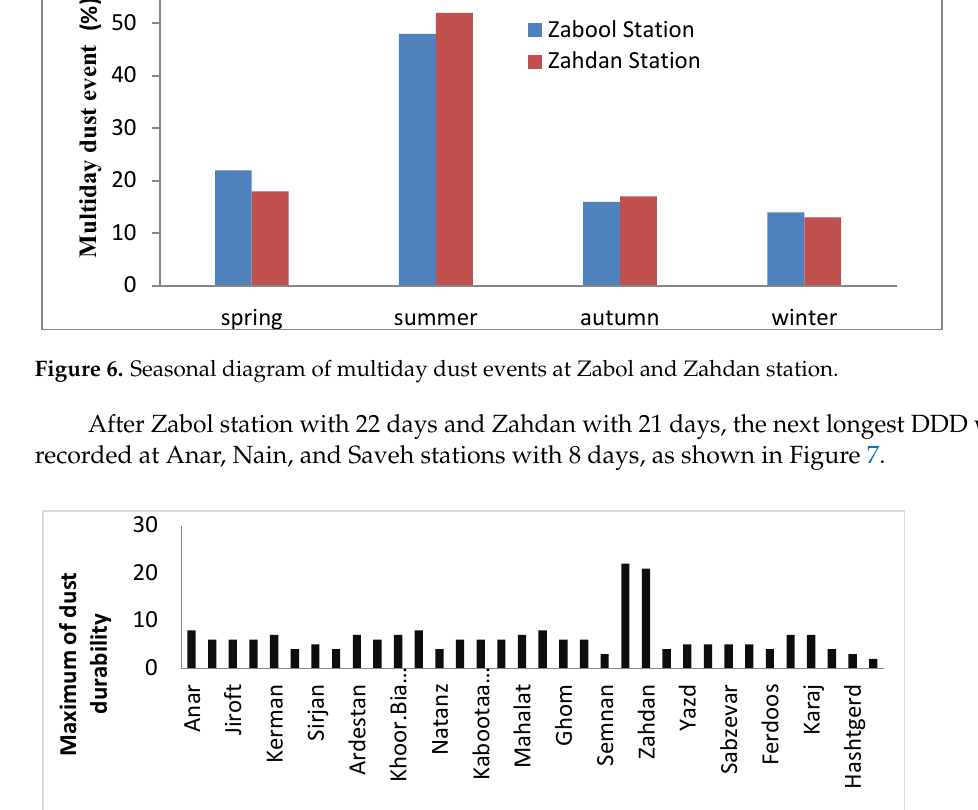
10 of 19 Figure 5. Annual-maximum dust days duration in Zabol and Zahdan stations 1999–2018 . A seasonal survey of the index station of the region (Zabol and Zahdan stations) shows that the highest frequency of dust events occurs in summer, followed by spring; in particular, in Zahdan and Zabol stations about 52% and 48% of multiday dust storms